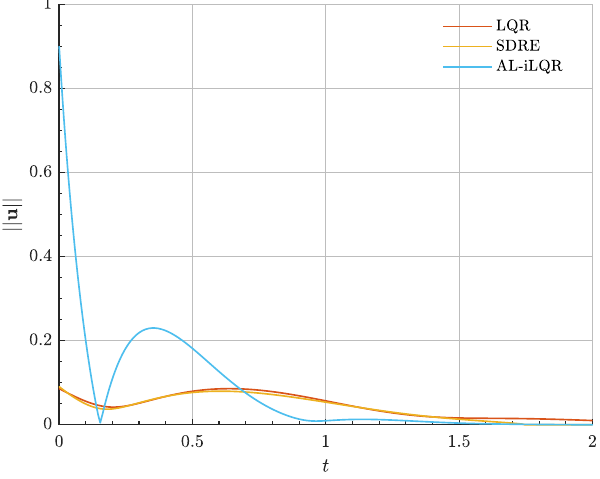
Figure 9. Control acceleration in mm/s 2 for the LQR, SDRE and AL-iLQR